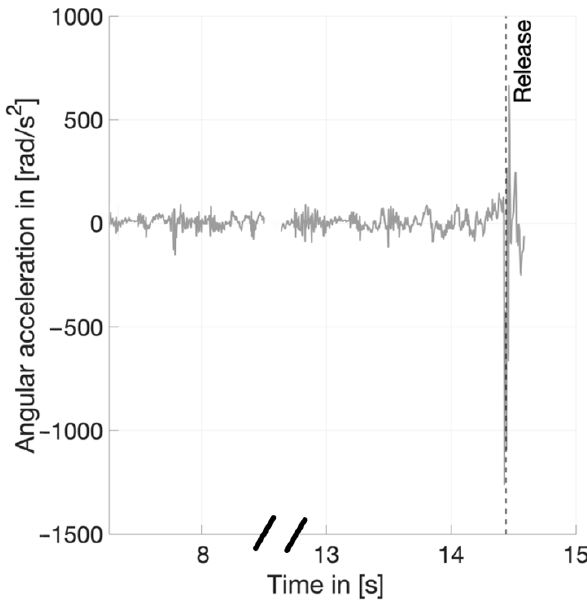
Figure 5. Determination of release frame (marked by dotted line) by means of the of angular acceleration course of the right hand.